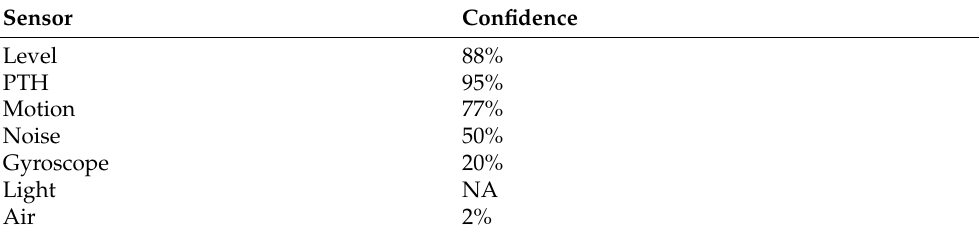
Table 15. Confidence percentage of real alerts from sensor network.